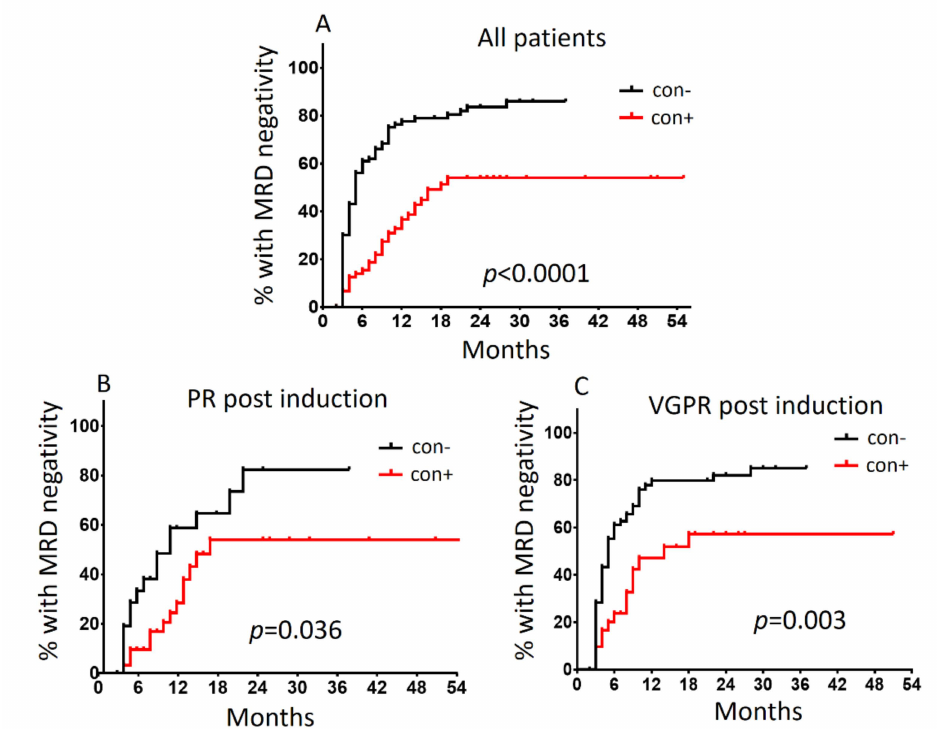
Figure 4. Time to MRD negativity achievement post ASCT according to graft contamination status for ( A ) all patients enrolled in the study ( n = 199), ( B ) patients who achieved PR post induction ( n = 61) and ( C ) patients who achieved VGPR post induction ( n = 109). con+, contaminated graft samples; con − , uncontaminated graft